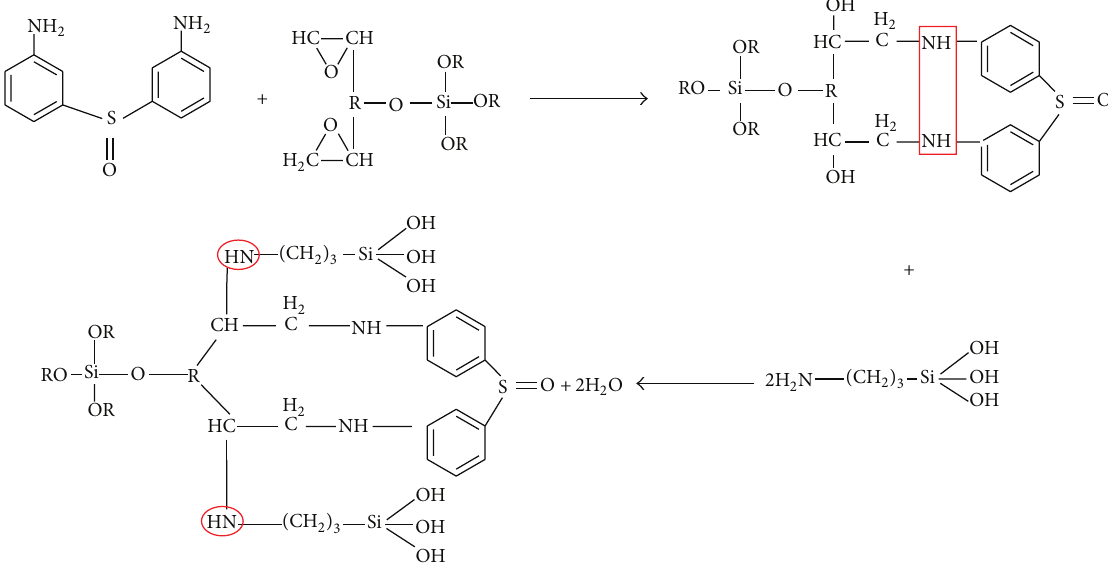
Figure 4: The structure of OER and its reaction mechanism with DDS and KH-550.